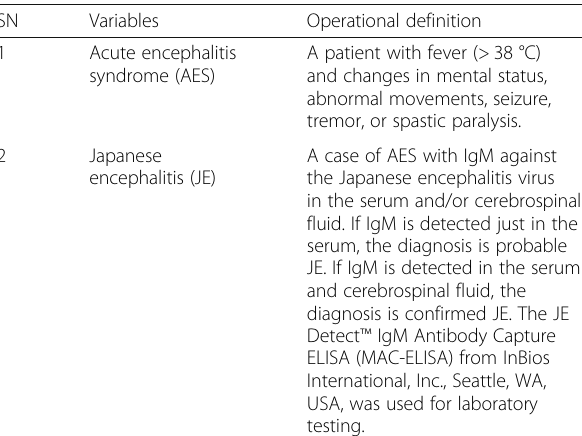
Table 1 Operational definitions for acute encephalitis syndrome and Japanese